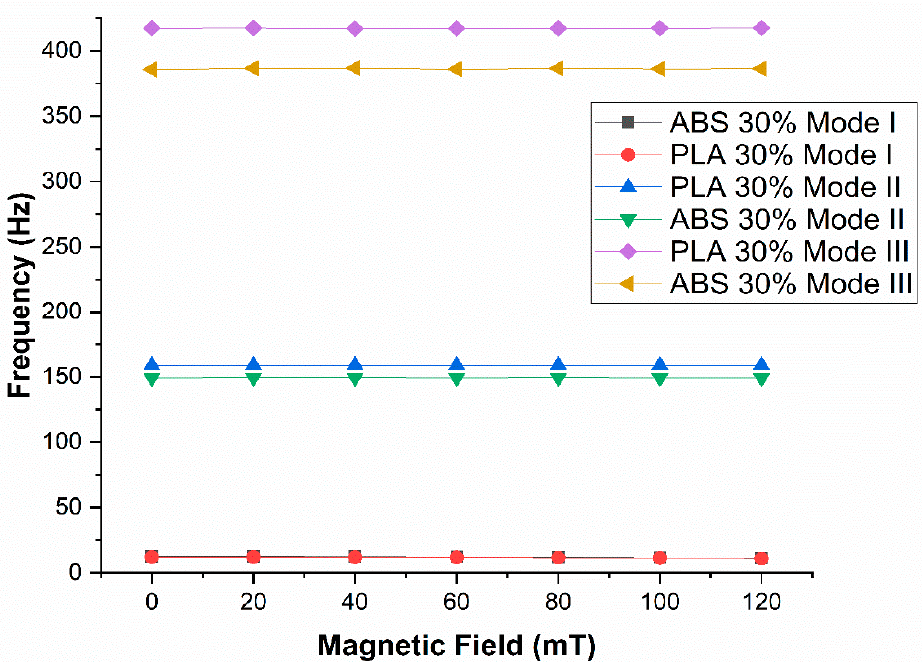
Figure 11. Variation of the natural frequency for different modes considering the magnetic field applied on sandwich structure with MRE honeycomb core of ABS and PLA honeycomb.